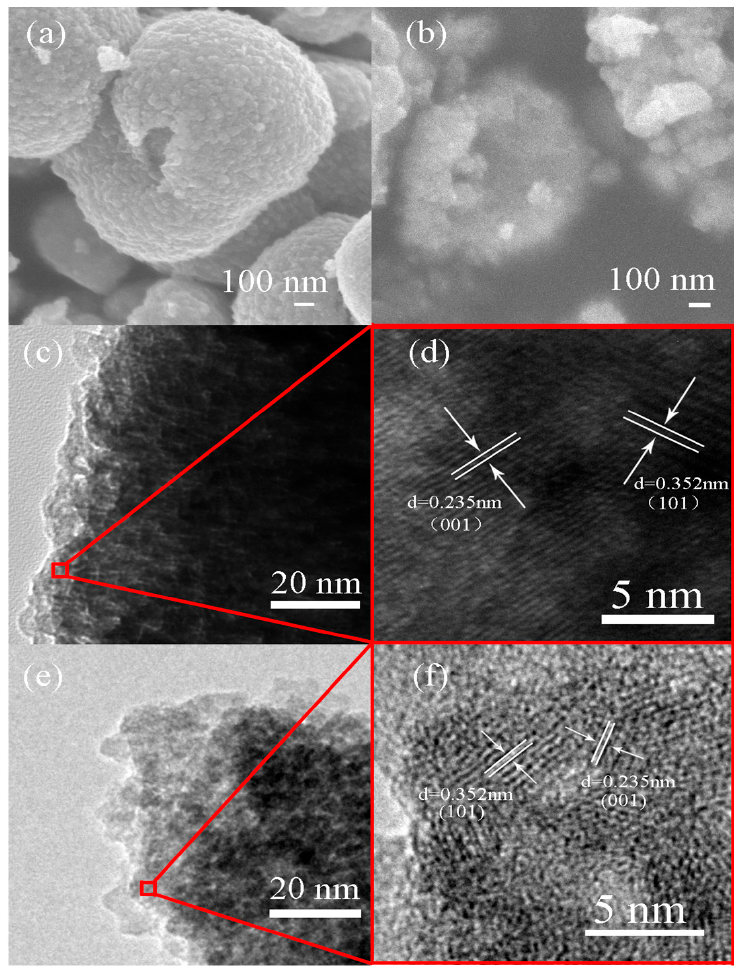
Figure 1. X ‐ ray diffraction (XRD) patterns of as ‐ prepared F ‐ TiO 2 and OH ‐ TiO 2 samples.